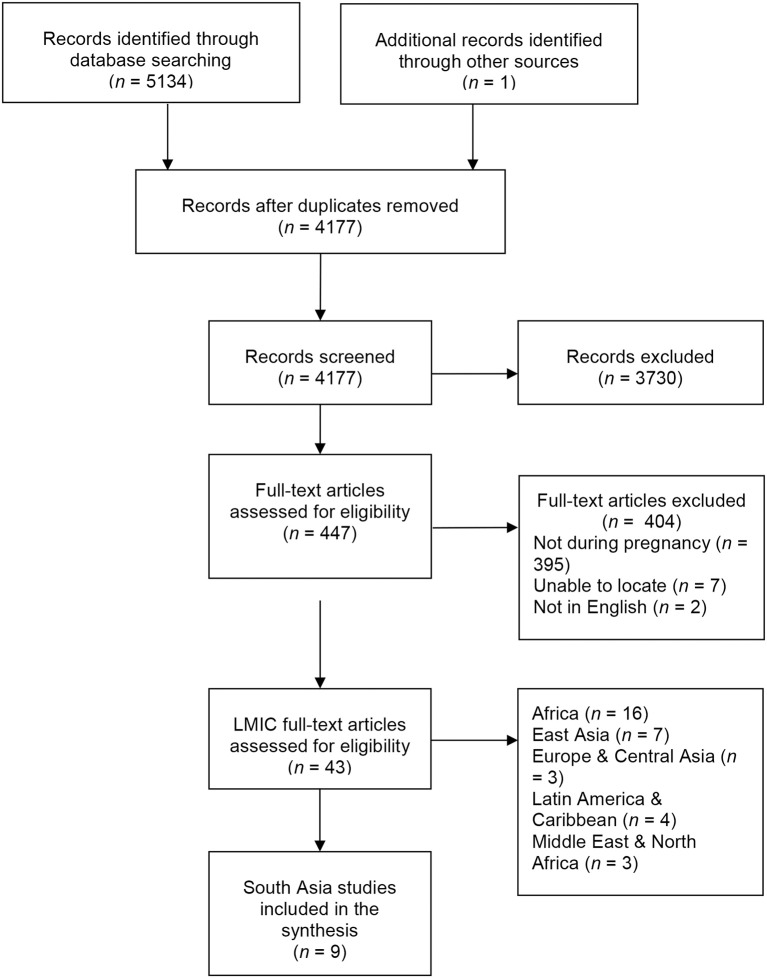
PRISMA flow diagram.